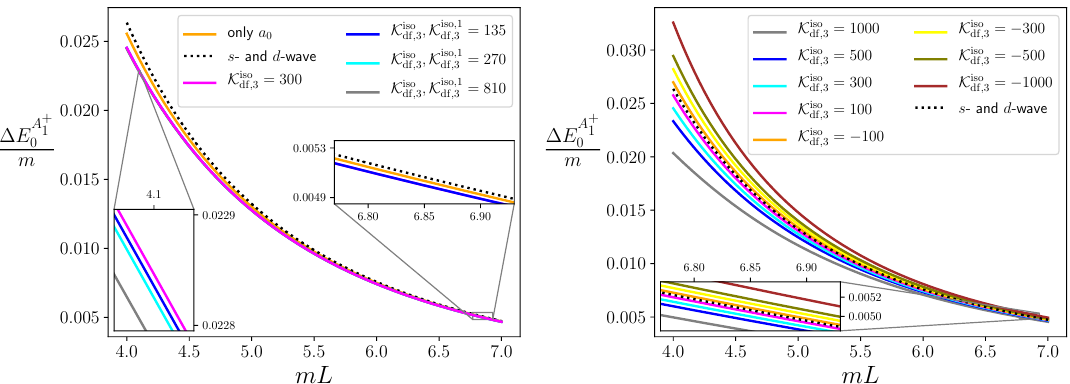
Figure 5. Energy shift for the ground state in the A + irrep, for which E free = 3 m . The two-particle 0 1 scattering parameters are those in eq. (4.7), aside from the orange curve in the left panel, where only a 0 is nonzero. The three particle scattering parameters are as indicated in the legend, and explained further in the text. We use the convention that a parameter value not given explicitly is set to the value given earlier. For example, the blue line in the left panel has the parameters set to (2 ;A ) (2 ;B ) iso ; 1 iso ; 2 iso = 300 and = 135, while = = = 0. df ; 3 df ; 3 df ; 3 df ; 3 df ; 3 K K K K K